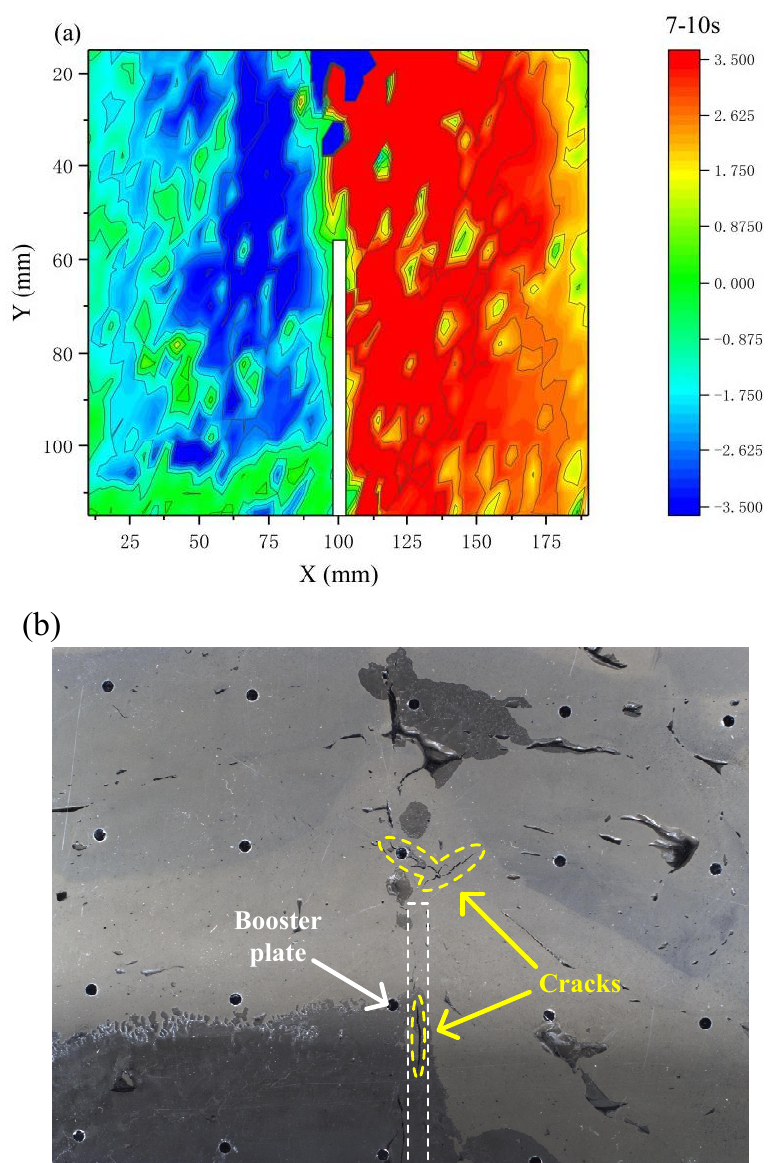
Figure 9. PIV results for a time period of 7~10 s of air boosting: ( a ) coloured contour on horizontal displacement; ( b ) slurry picture taken on time instant t * = 10 s.